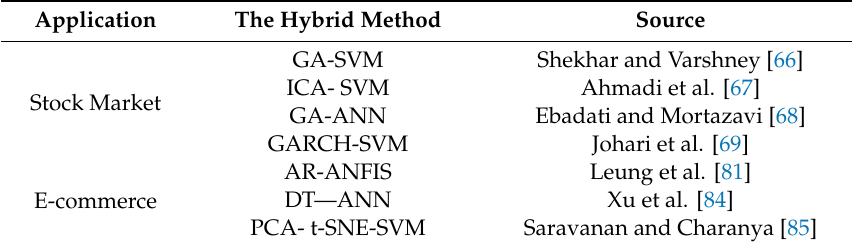
Table 10. List of hybrid machine learning models employed in economic related